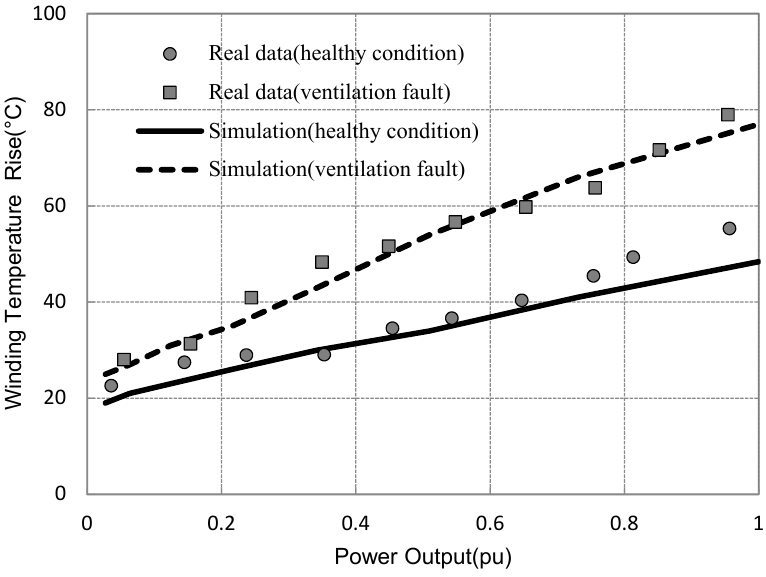
Figure 13. Winding temperature rise against normalized power output when DFIG under healthy condition and with ventilation system